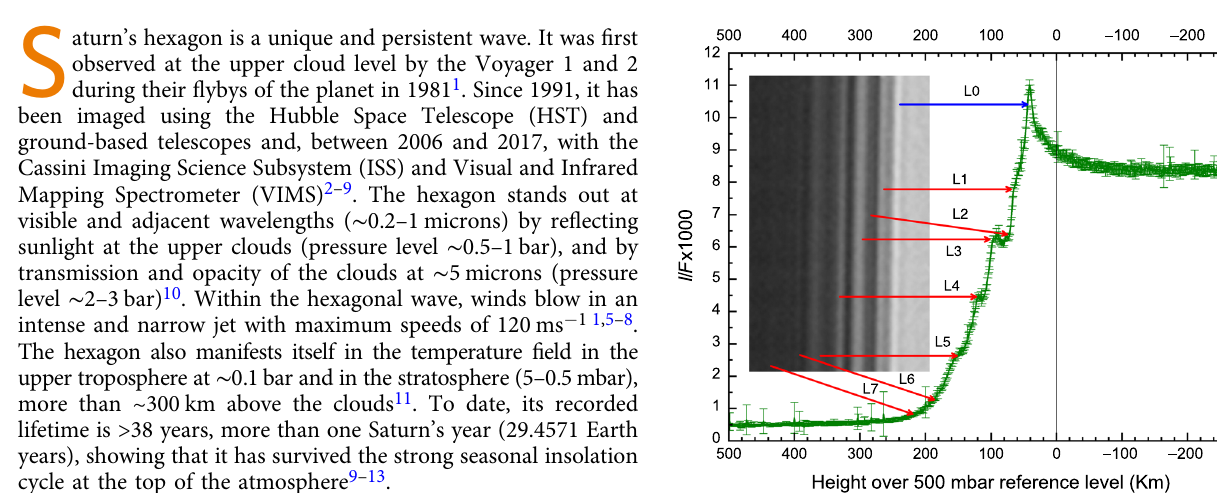
re fl ectivity ( I / F times 1000) as a function of the vertical distance across the limb in the 890-nm methane absorption band fi lter. The inset shows an image of the haze layers in this fi lter and their identi fi cation (L0 – L7) in the re fl ectivity scan across Saturn ’ s limb. The haze layers extend meridionally at least from latitude + 75.8°N to +